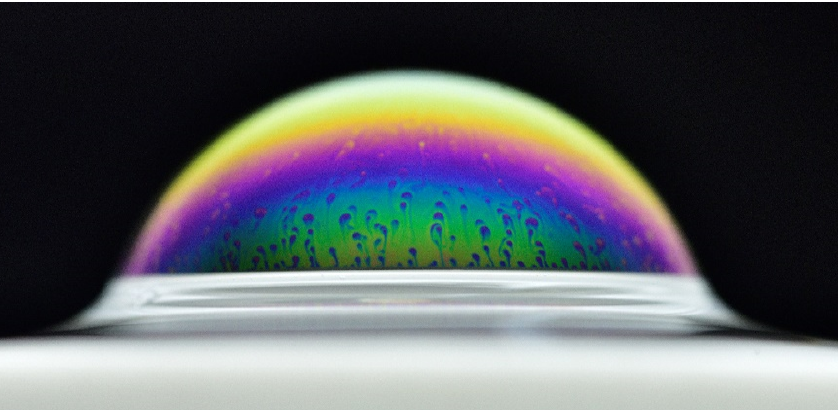
Figure 1. Artistic photography by Serge Guichard of a centimetric surface bubble during thinning. Marginal regeneration patches can be observed at the surface of a bubble. The bubble is stabilised by TTAB at a concentration of 0.5 times the critical micelle concentration